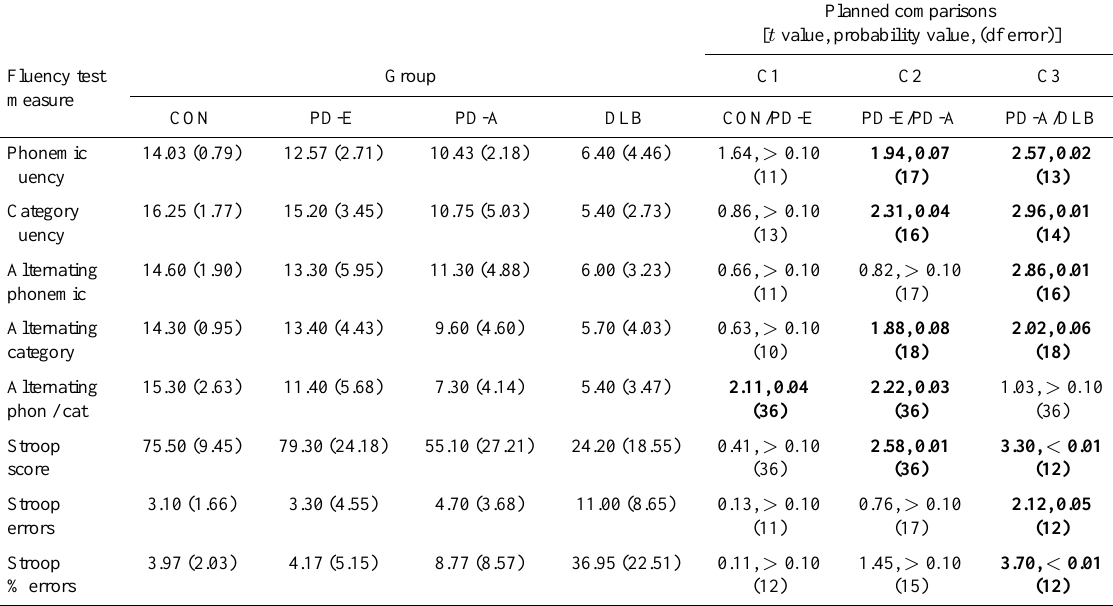
Table 5 Means, standard deviations, and planned comparisons for frontal test measures Planned comparisons [ t value, probability value, (df